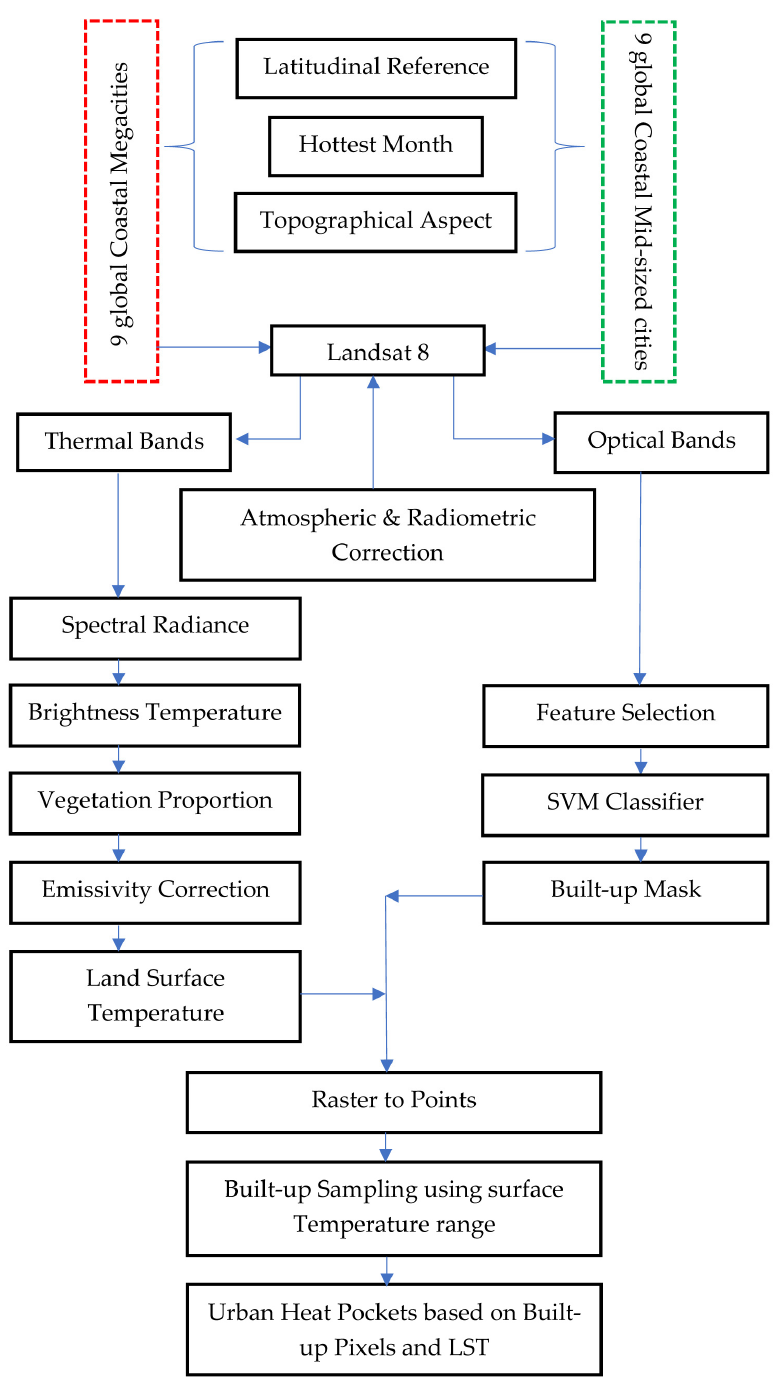
Figure 2. Methodological flowchart of the study.